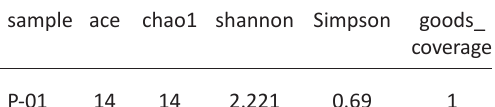
Table 3. Alpha diversity through a series of statistical